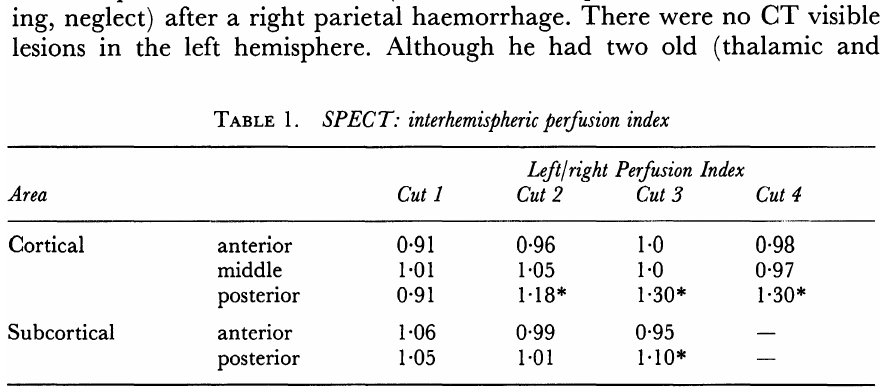
TABLE 1. SPECT: interhemispheric perfusion